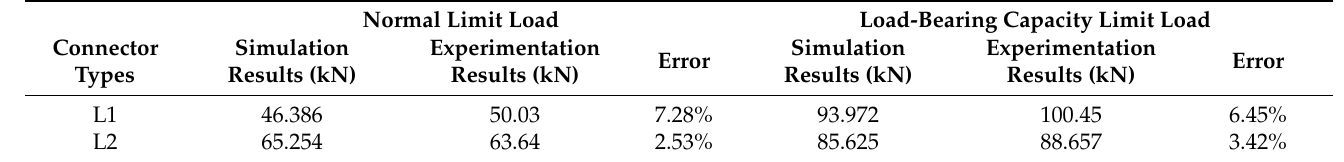
Table 7. Comparison between numerical analysis and experimental results.